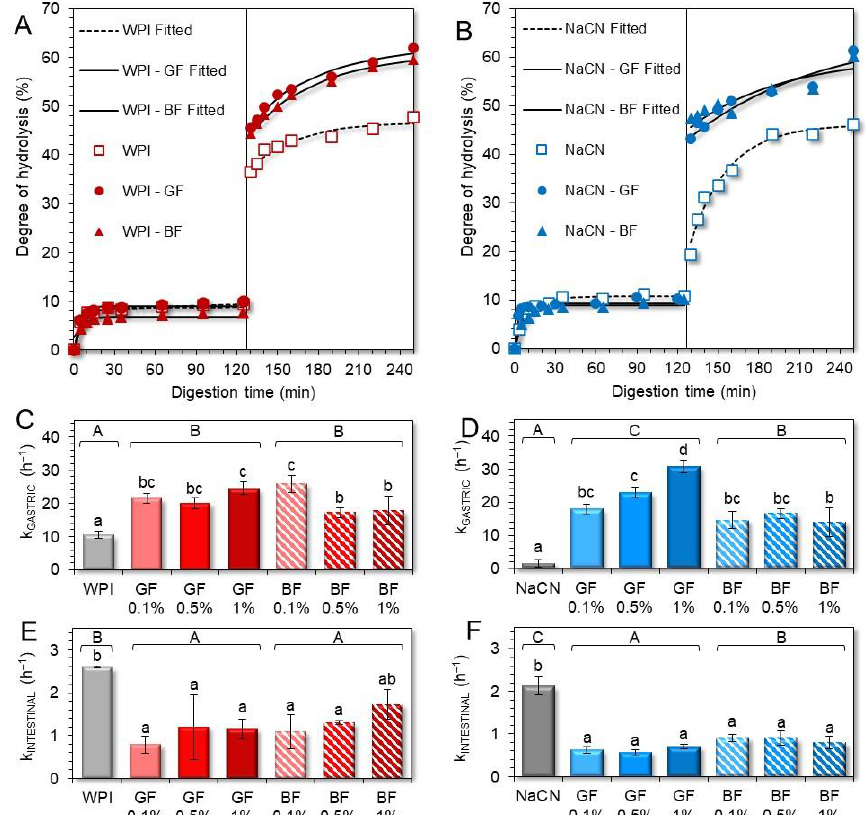
Figure 9. Degree of protein hydrolysis in the WPI-( A ) and NaCN-( B ) based gastric and intestinal phases as influenced by the phenotype and concentration (0.1 – 1% wt.) of flaxseed gum. The protein hydrolysis rates of WPI and NaCN during gastric (k GASTRIC ) and intestinal (k INTESTINAL ) steps are displayed in ( C – F ). a− d, A − C Different letters between the samples denote a significant difference.